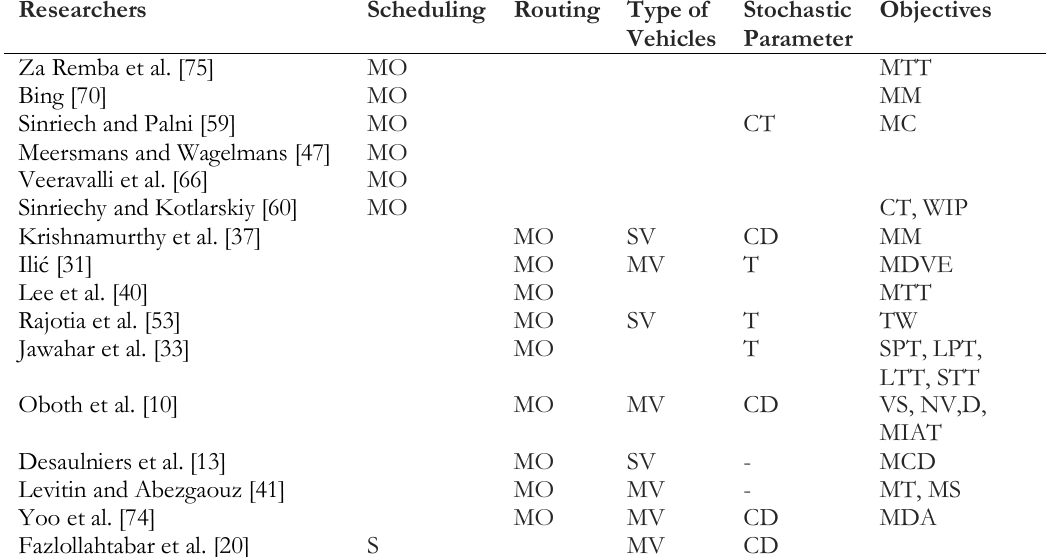
Table 1. Review of the previous studies on the AGV location-routing